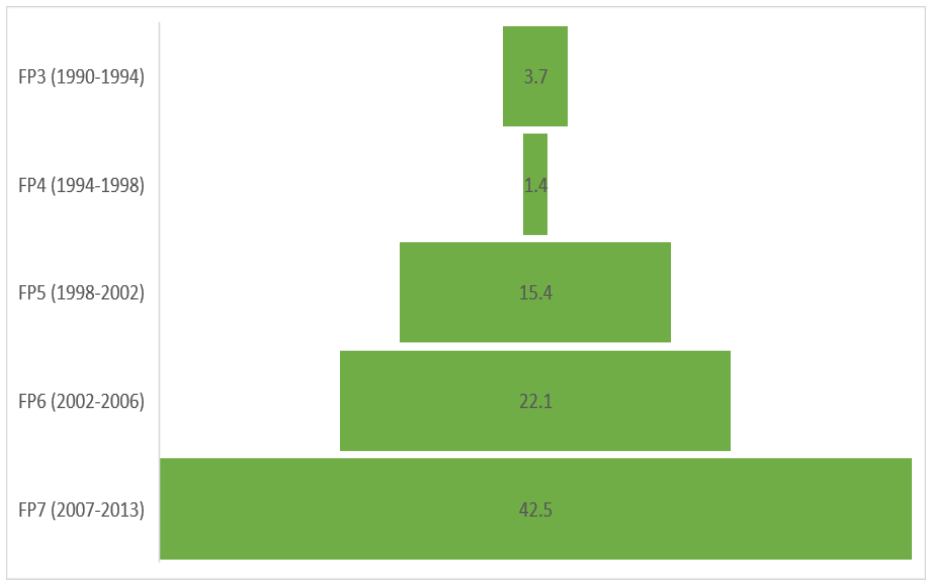
Figure 1. Funding of organic farming research in the EUs framework programs’ FP (million euros). Source: CORDIS database, https://cordis.europa.eu/project/rcn/111296_en.html [77].